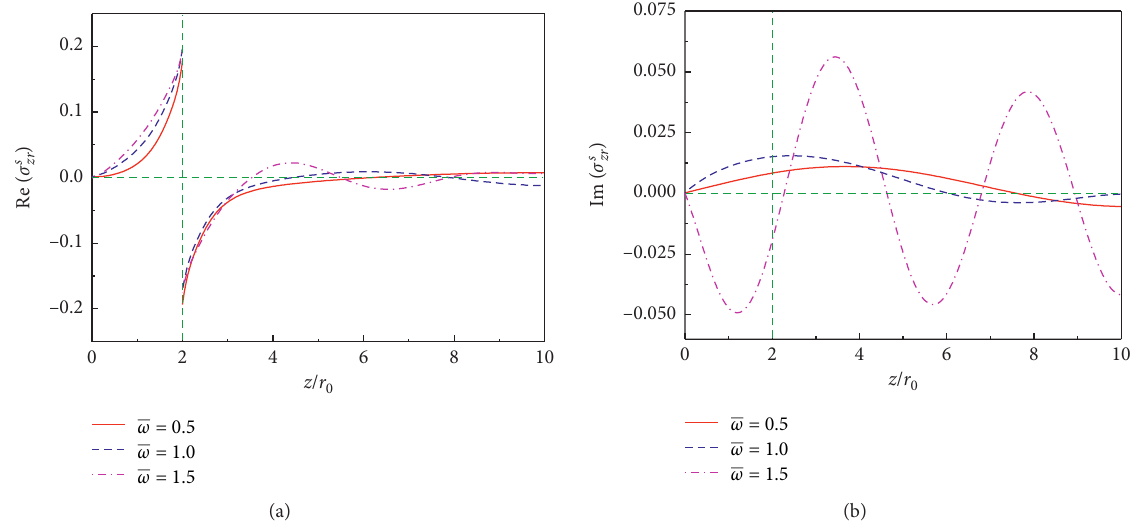
Figure 7: Lateral stress σ s zr induced by unit lateral load on π s : (a) real part of lateral stress; (b) imaginary part of lateral stress.